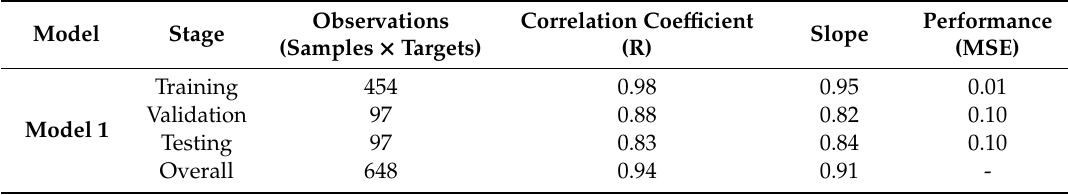
Figure 5. Overall regression of ( a ) Model 1 to predict the physicochemical parameters using near-infrared absorbance values as inputs, ( b ) Model 2 to predict the intensity of sensory descriptors using the physicochemical parameters as inputs, and ( c ) Model 3 to predict the liking of sensory attributes using the physicochemical parameters as inputs; while ( d ) shows the receiver operating characteristics (ROC) curve from Model 4 to classify samples into the three treatments (control, sonication in fermentation, and sonication in carbonation). Table 5. Results from the artificial neural network regression (Models 1–3) and classification (Model 4) models. Performance was calculated based on the mean squared error